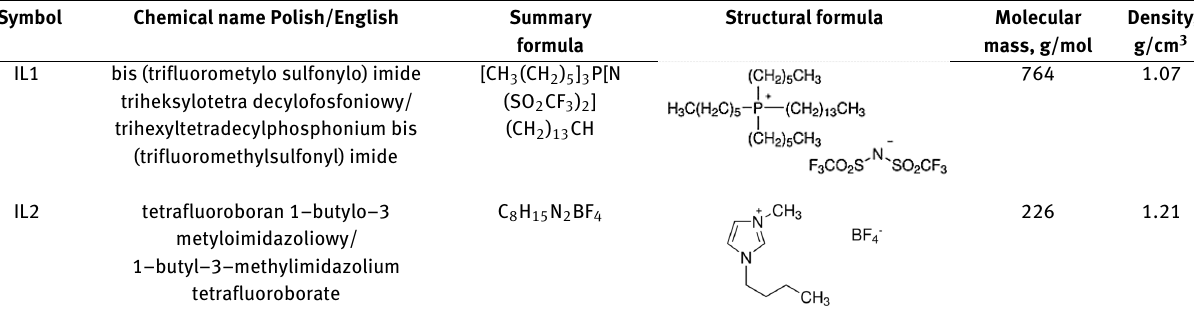
Table 2: Properties of the cutting fluid containing zinc aspartate Colour Smell pH Density, from orange to red specific 1.25 solube